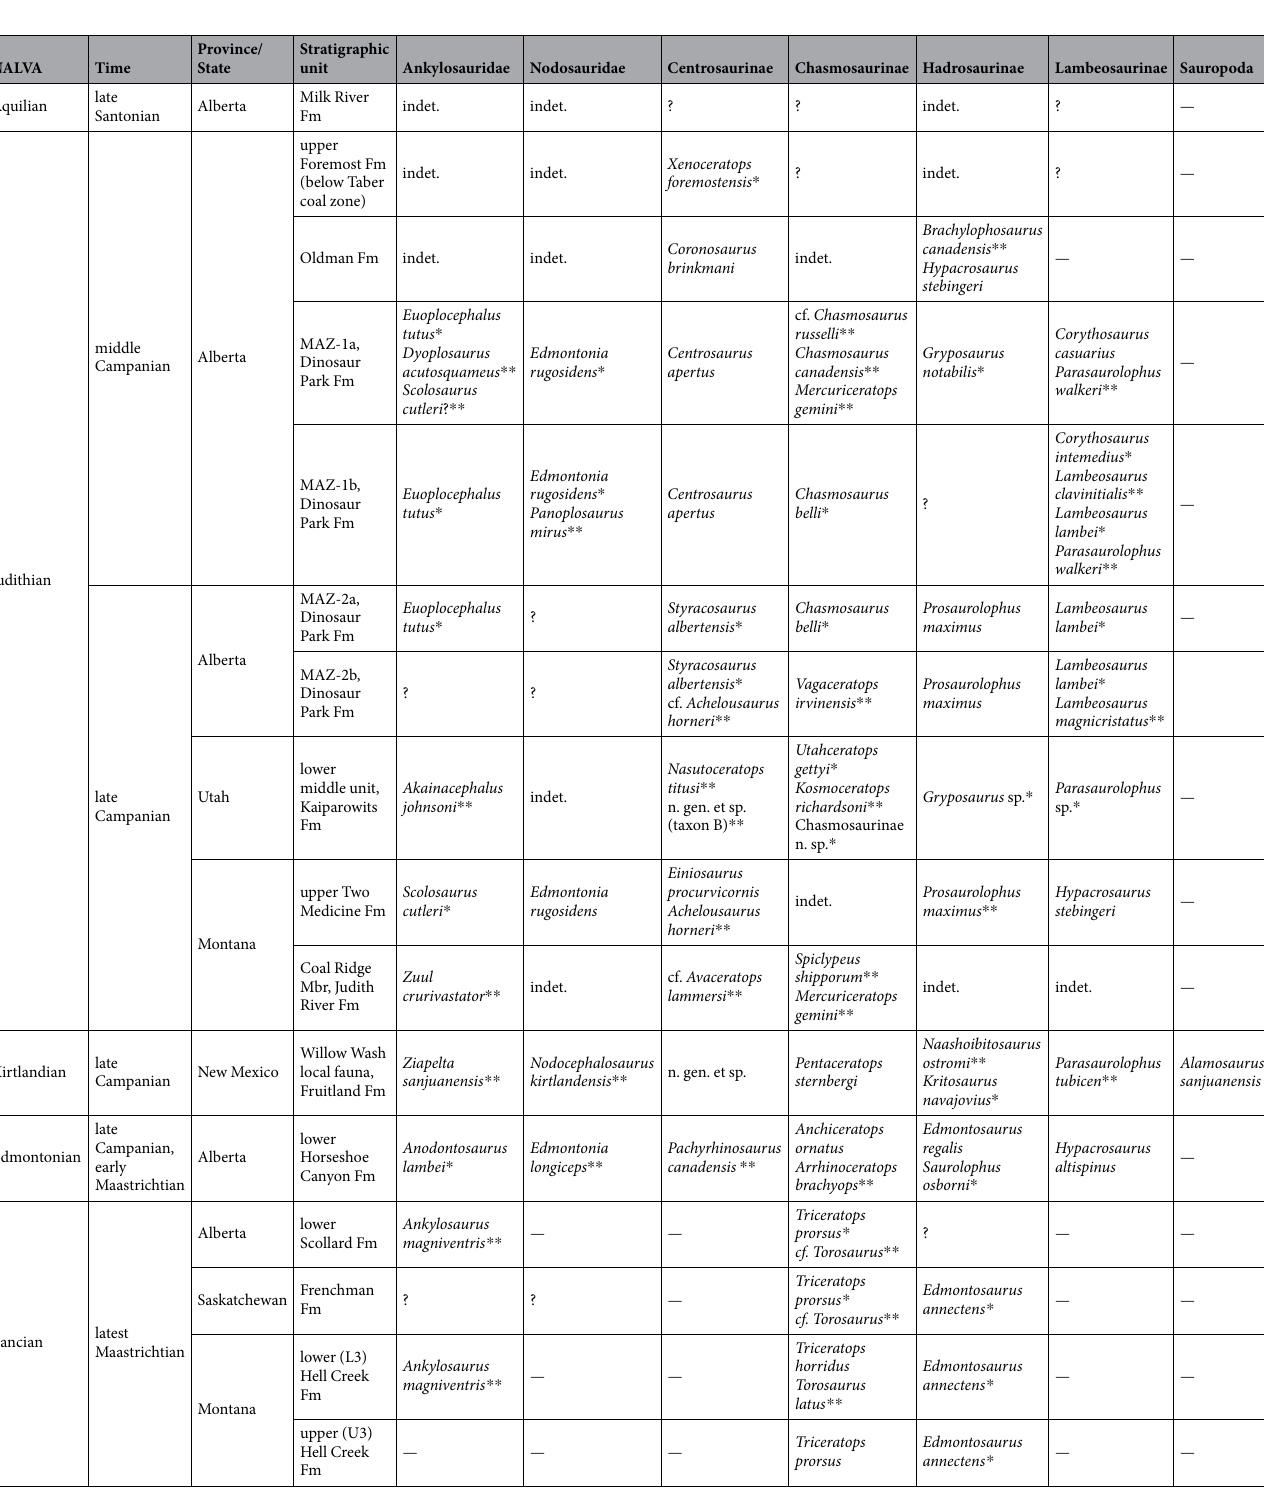
Table 4. Megaherbivore community structure through the Late Cretaceous. Taxa marked by a single asterisk ( * ) are rare (5–10 specimens), and those marked by double asterisks ( ** ) are very rare ( < 5 specimens). Question marks (?) denote uncertainty regarding the presence of a particular taxon (e.g., definitive ceratopsid material that cannot be positively attributed to either Centrosaurinae or Chasmosaurinae); dashes (–) denote absence of material that could be justifiably assigned to a particular taxon, given current